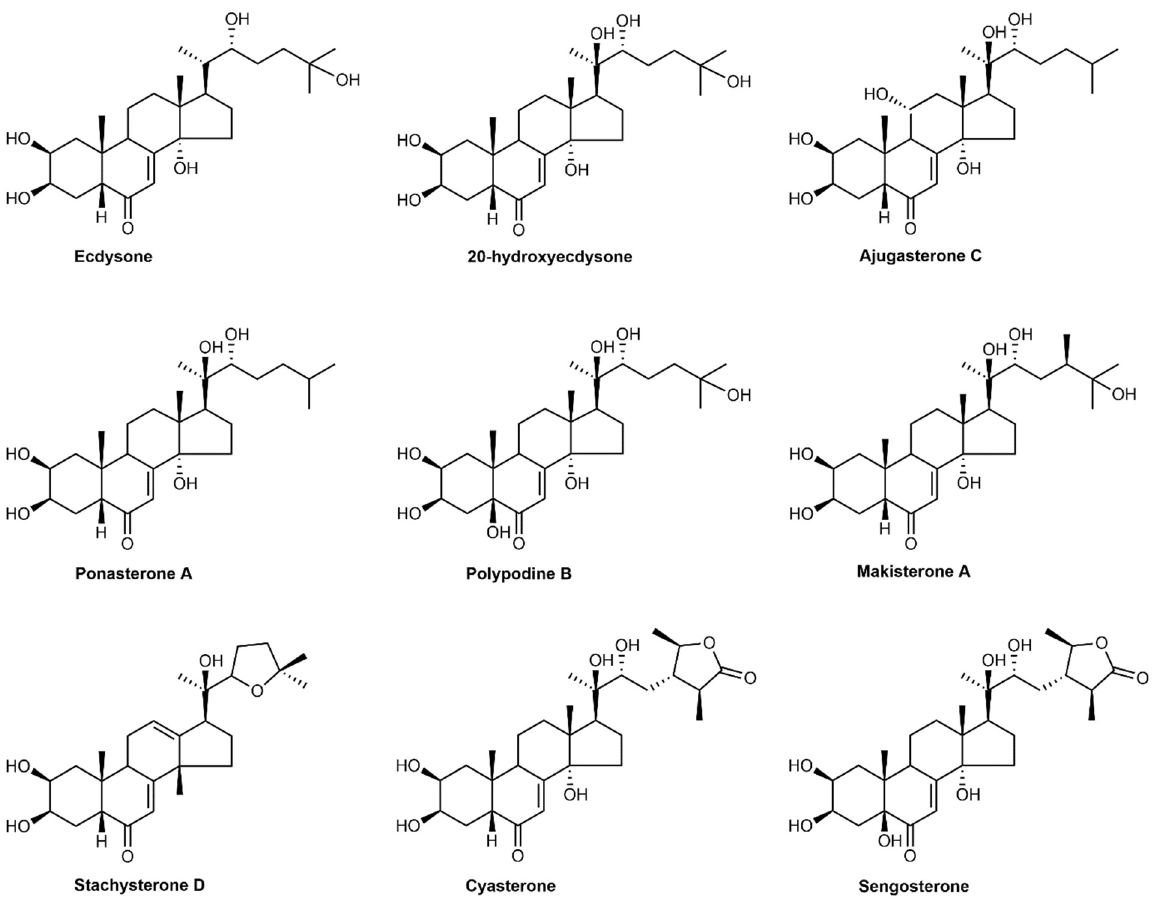
Figure 1. Structures of widely distributed phytoecdysteroids.